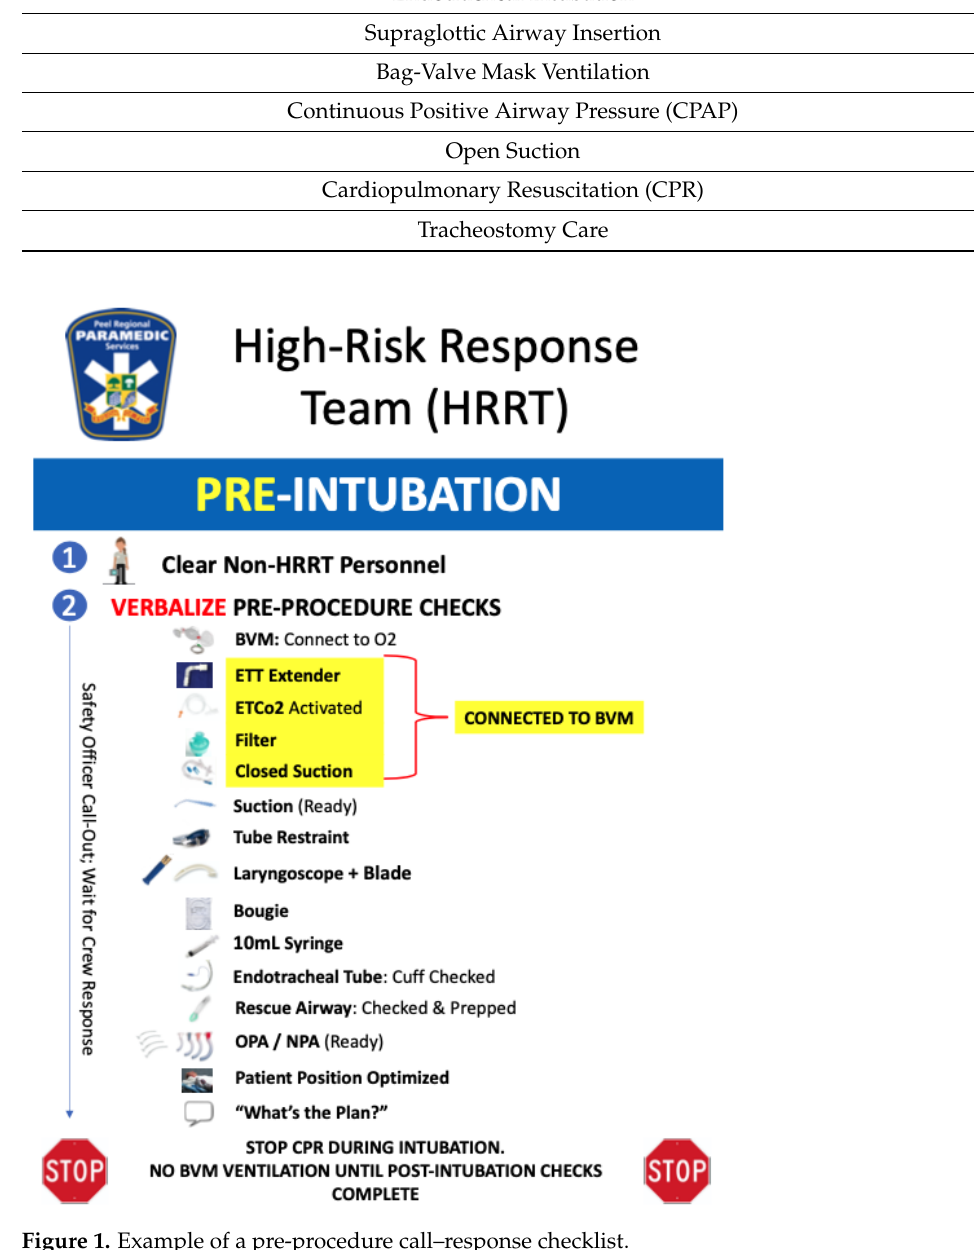
Figure 1. Example of a pre-procedure call – response checklist.